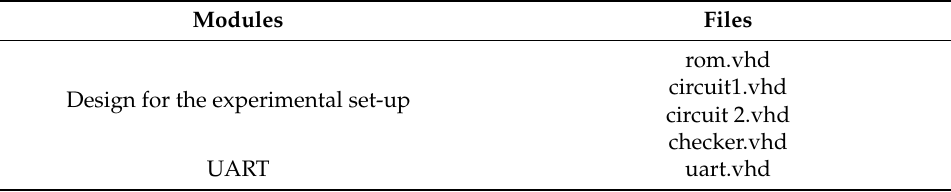
Table 2. Projects files before SEM IP core.